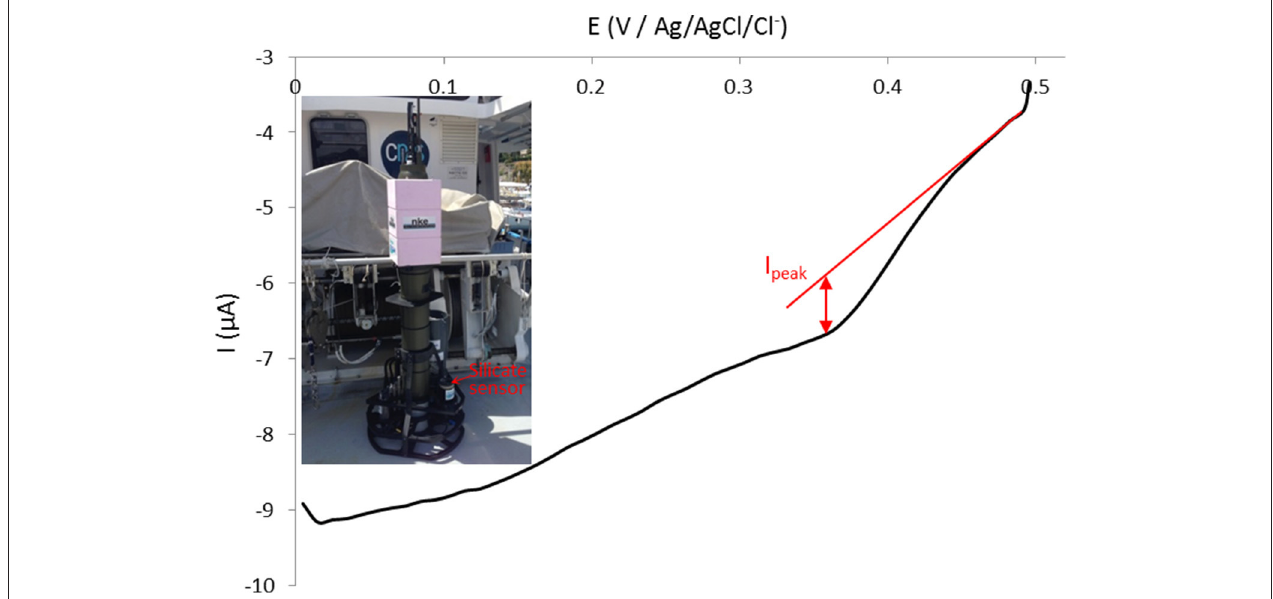
FIGURE 9 | Silicate sensor implemented on PROVOR float (inset) transmitted through satellite cyclic voltammogram (forward cycle) at 100mV s − 1 on gold working electrode (Ø = 2mm) recorded at 14 ◦ C and 160m depth off Villefranche-sur-Mer, France (May 2017).